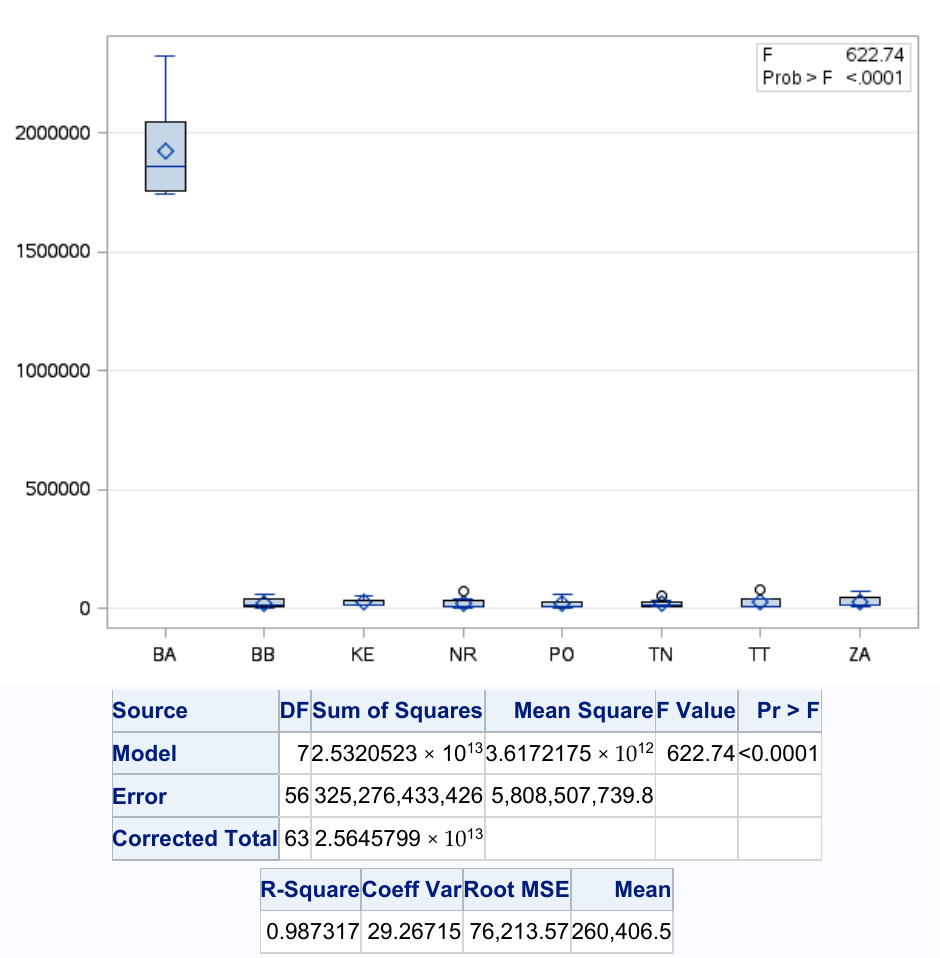
Figure 6. One-factor analysis of material recovery of municipal waste on the regions of Slovakia. Source: Based on of data collected by Statistical Office of Slovak Republic [29].